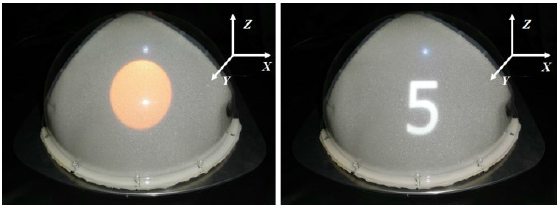
Figure 3. The test settings – the participants sit in front of the Touch Ball and apply force onto it; P =